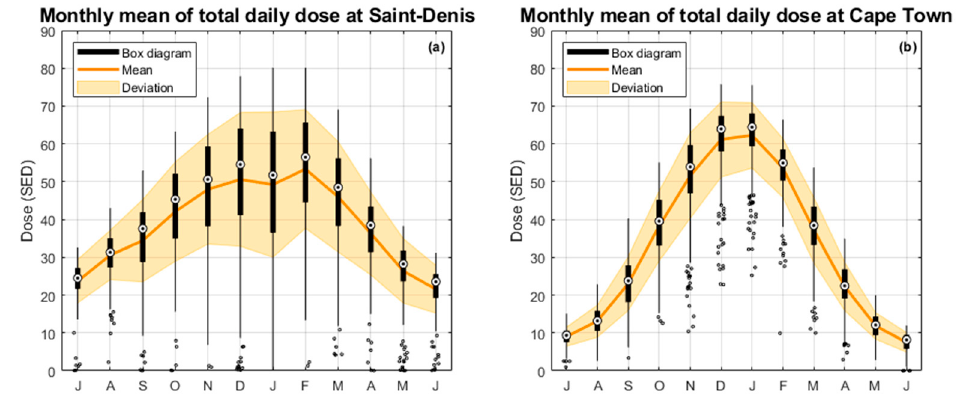
Figure 3. Monthly climatology of total daily erythemal dose at Saint-Denis ( a ) and at Cape Town ( b ). Box diagrams are represented in black for each month (the central value is the median, the box edge is set at 25 th and 75 th percentiles, the whiskers show the extreme values, excluding outliers, which is represented by single black dots). The orange line shows the monthly mean and the orange shading shows one standard deviation. Months on the X-axis have been reorganized to highlight the austral summer, which appears in the middle of the plot.